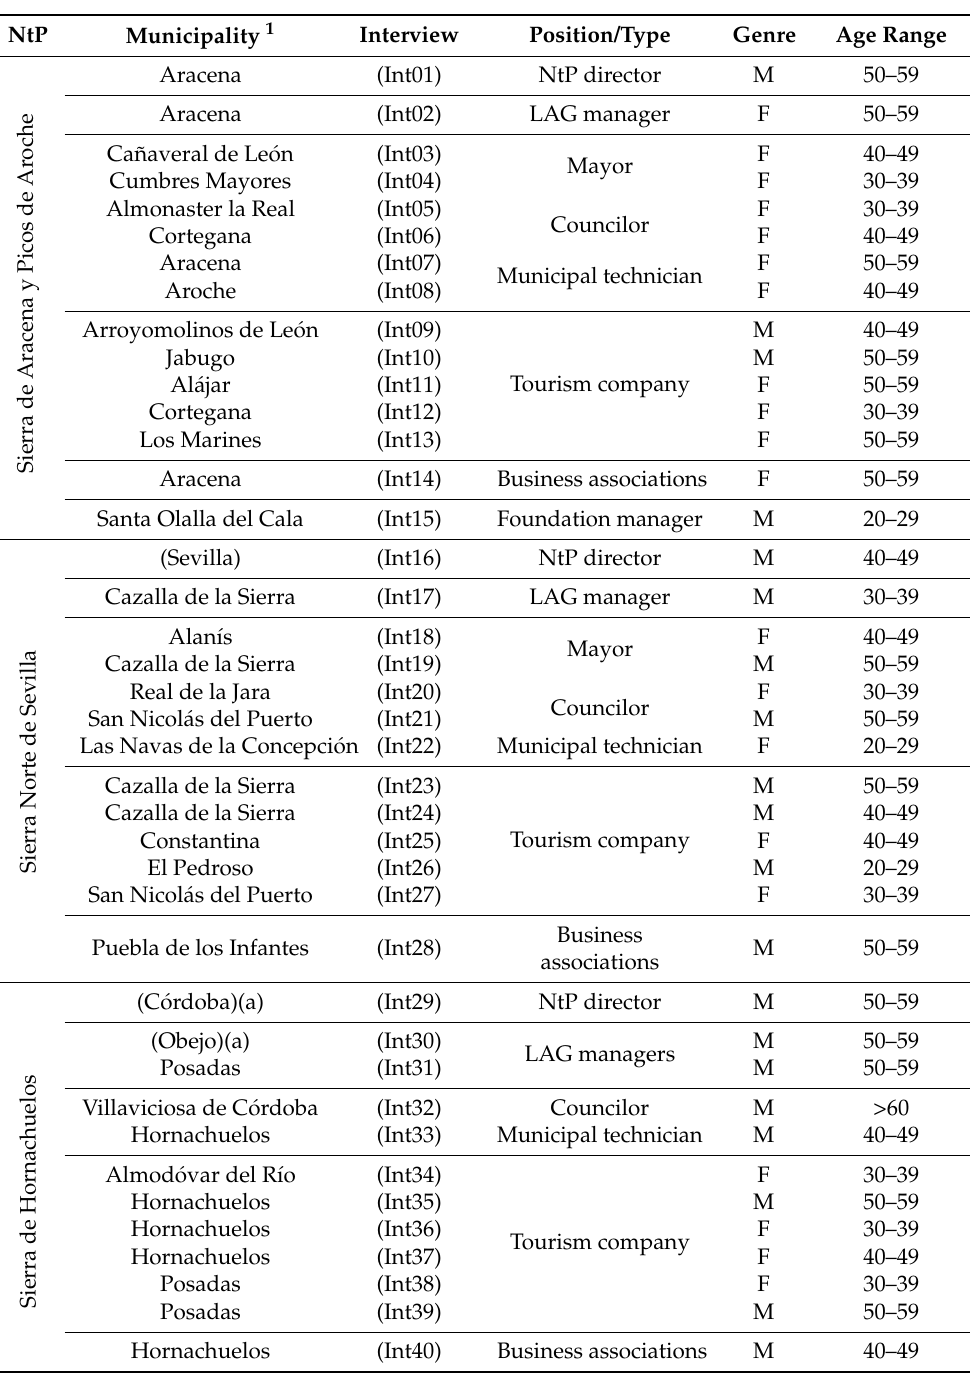
Table 2. Conducted